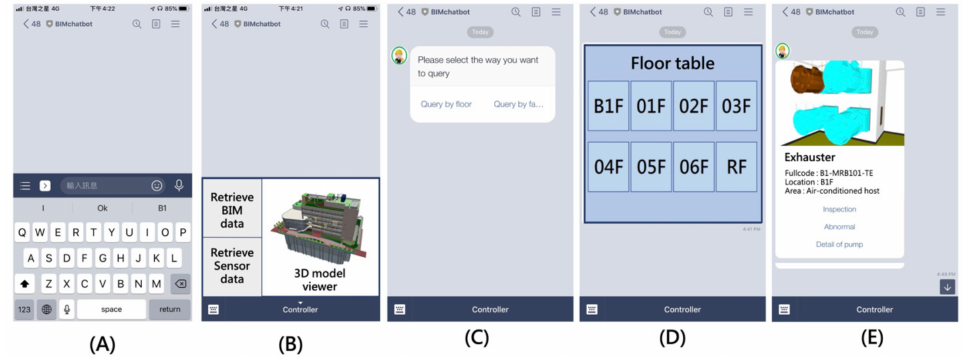
Figure 12. The main interface and menus of the chatbot: ( A ) the message input bar, ( B ) the rich menu, ( C ) confirm template, ( D ) imagemap message, and ( E ) carousel